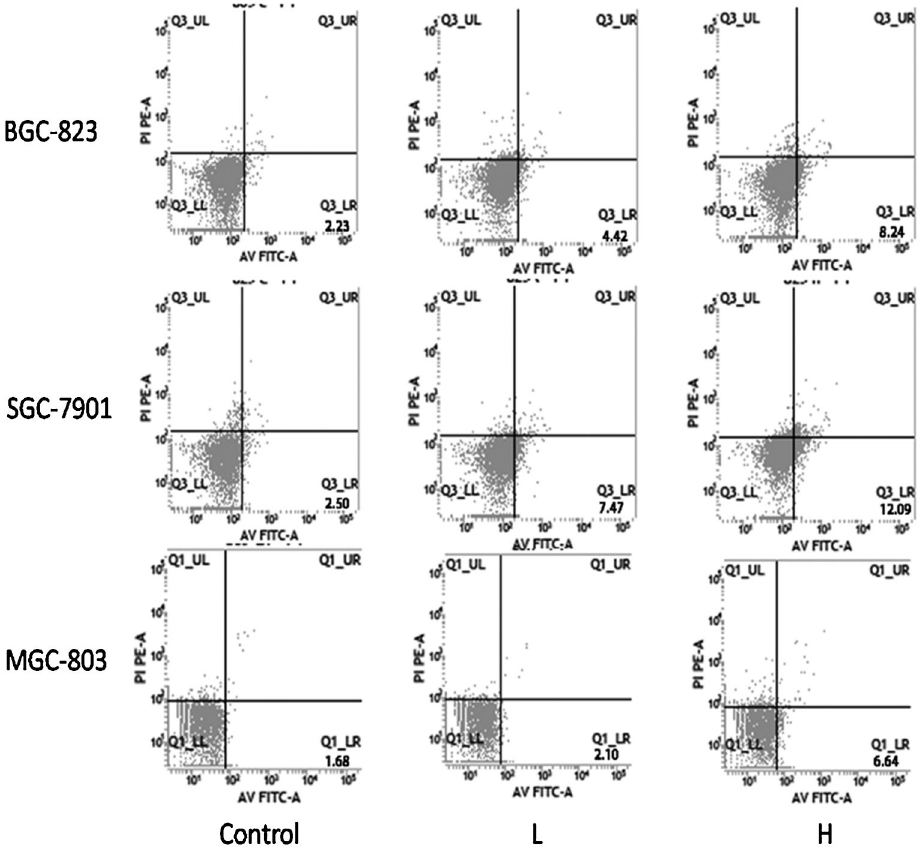
Figure 2. S-adenosylmethionine (SAM) enhanced apoptosis in gastric cancer cells. Flow cytometry analyses of MGC-803, SGC-7901, and BGC-823 after SAM treatment at 2 mM (L) and 4 mM (H) for 3 days compared to negative controls.